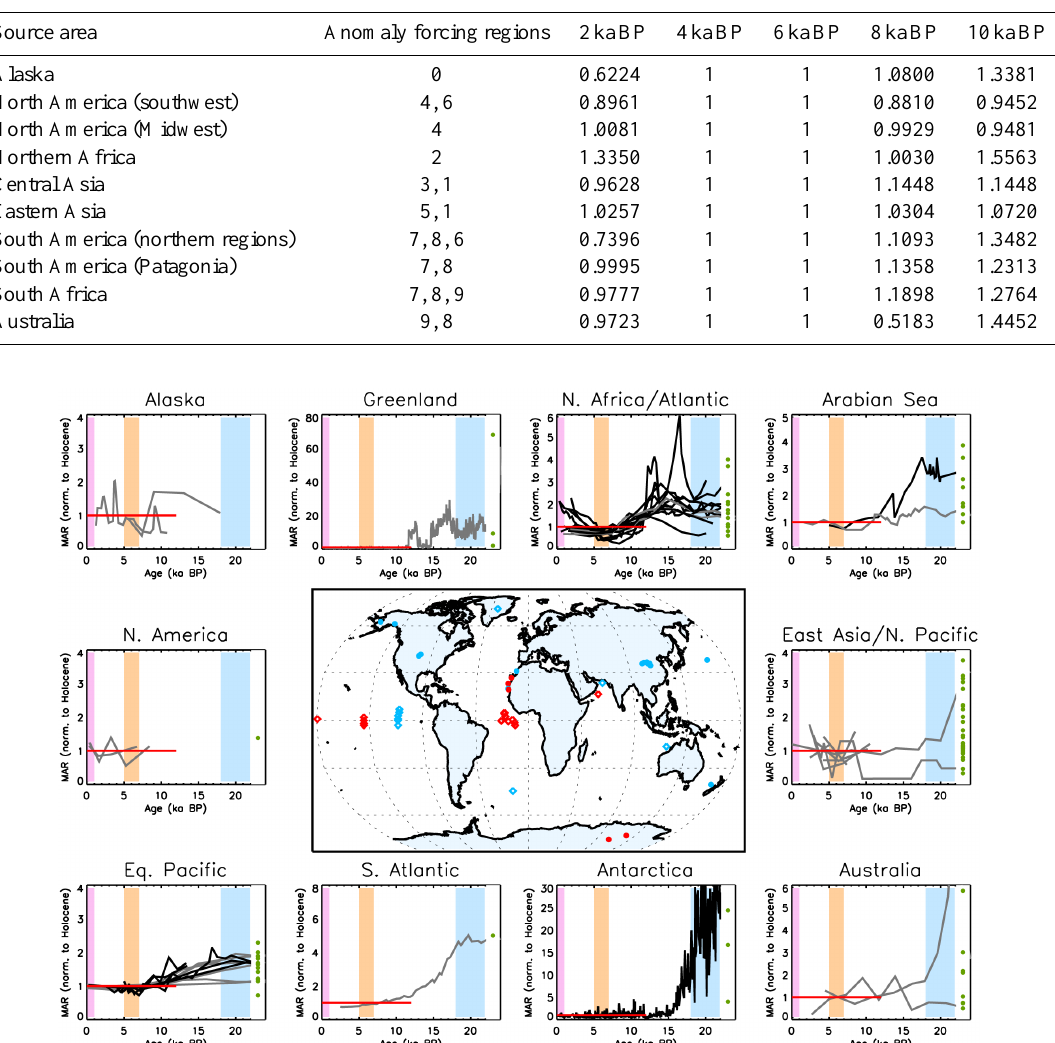
Figure 5. Overview of the data compilation. Central plot: global overview of the location of the paleodust records. Color indicates the confidence level (red: high confidence; blue: medium confidence). Marker’s shape indicates whether size distributions or classes are available (filled circles: yes; empty diamonds: no). Framing plots: time series of bulk dust MAR in the different areas, normalized to their Holocene (0– 12kaBP) average (red solid line for reference, which represents the time span over which DMARs were averaged in the original DIRTMAP; Kohfeld and Harrison, 2001). Black solid lines represent high-confidence records; gray lines identify medium-confidence records. Records are plotted in the 0–22kaBP interval to allow a comparison with DIRTMAP3 (Maher et al., 2010) data (as reported in Albani et al., 2014), represented by their glacial–interglacial ratio (green solid circles). Vertical color shading bands highlight the last millennium (pink), the MH (5–7kaBP, salmon), and the Last Glacial Maximum (18–22kaBP, light